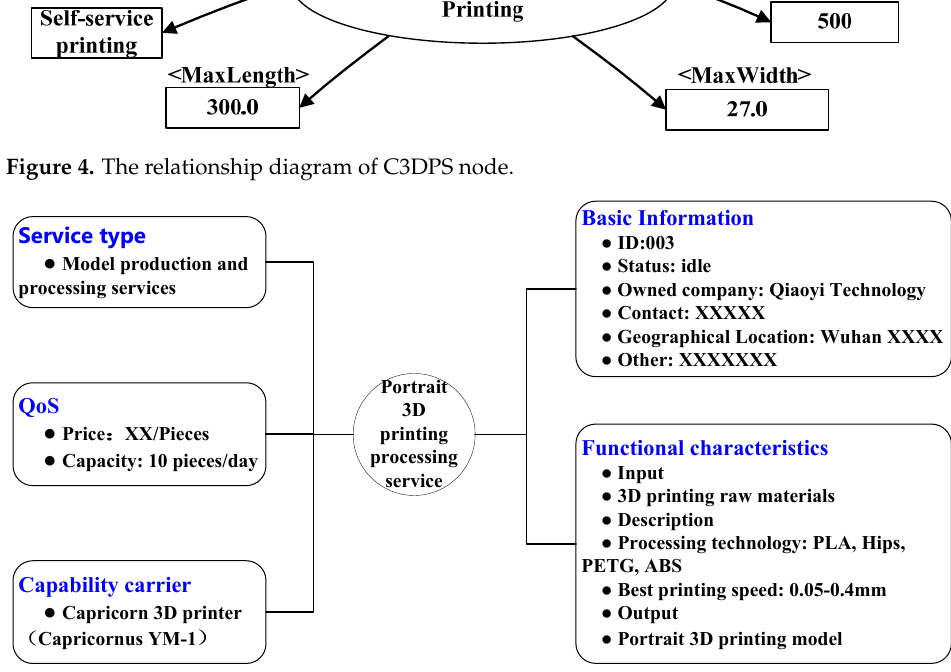
Figure 5. The description diagram of C3DPS.